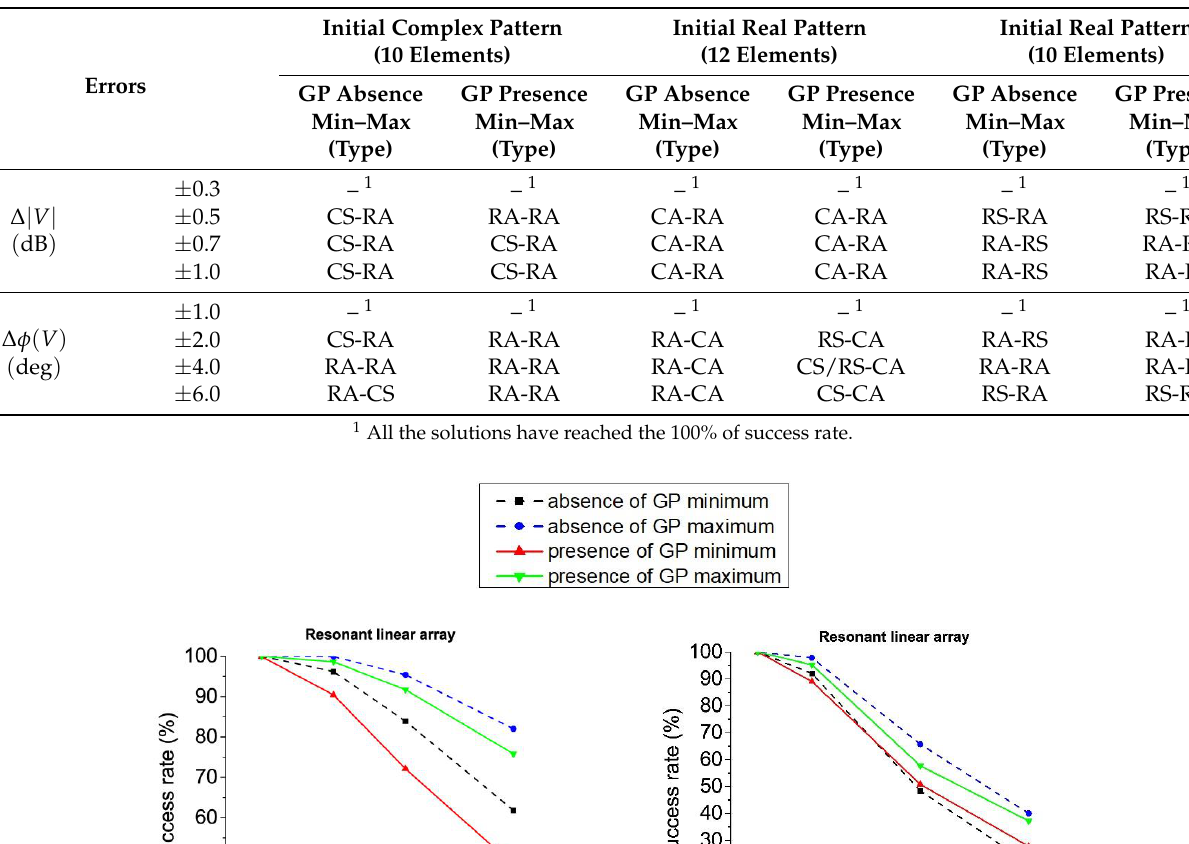
Figure 12. Tolerance to errors of the linear array of half-wavelength dipoles: Errors in amplitude in absence and presence of ground plane ( left ); errors in phase in absence and presence of ground plane ( right ). Table 8. Nature of the solutions with maximum and minimum rate of success in tolerance analysis of Figure 12: Linear array of half-wavelength dipoles in absence and in presence of ground plane.